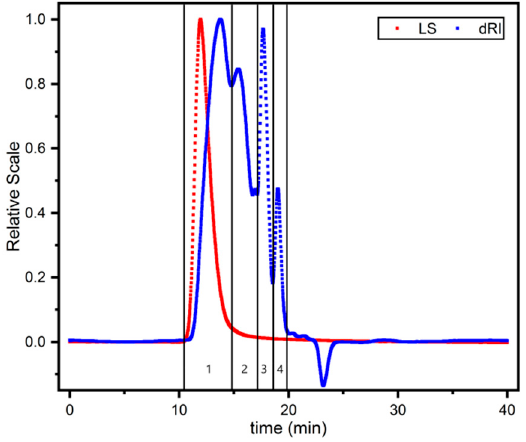
Figure 2. HPSEC–MALLS–RID chromatogram of RG polysaccharides sample. Table 2. Results of molecular weight determination of RG polysaccharides. Localities